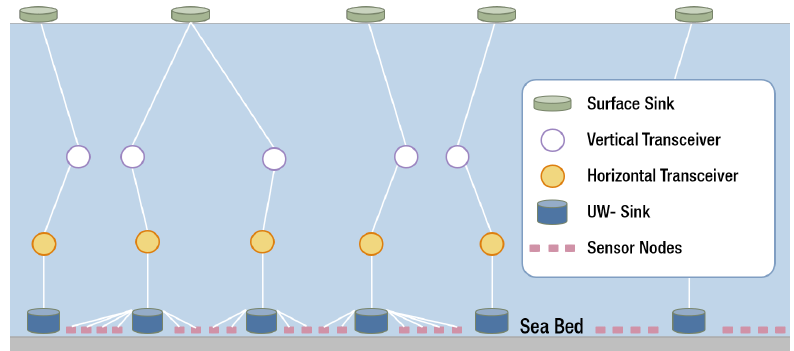
Figure 2. Two dimensional (2D) UWSN